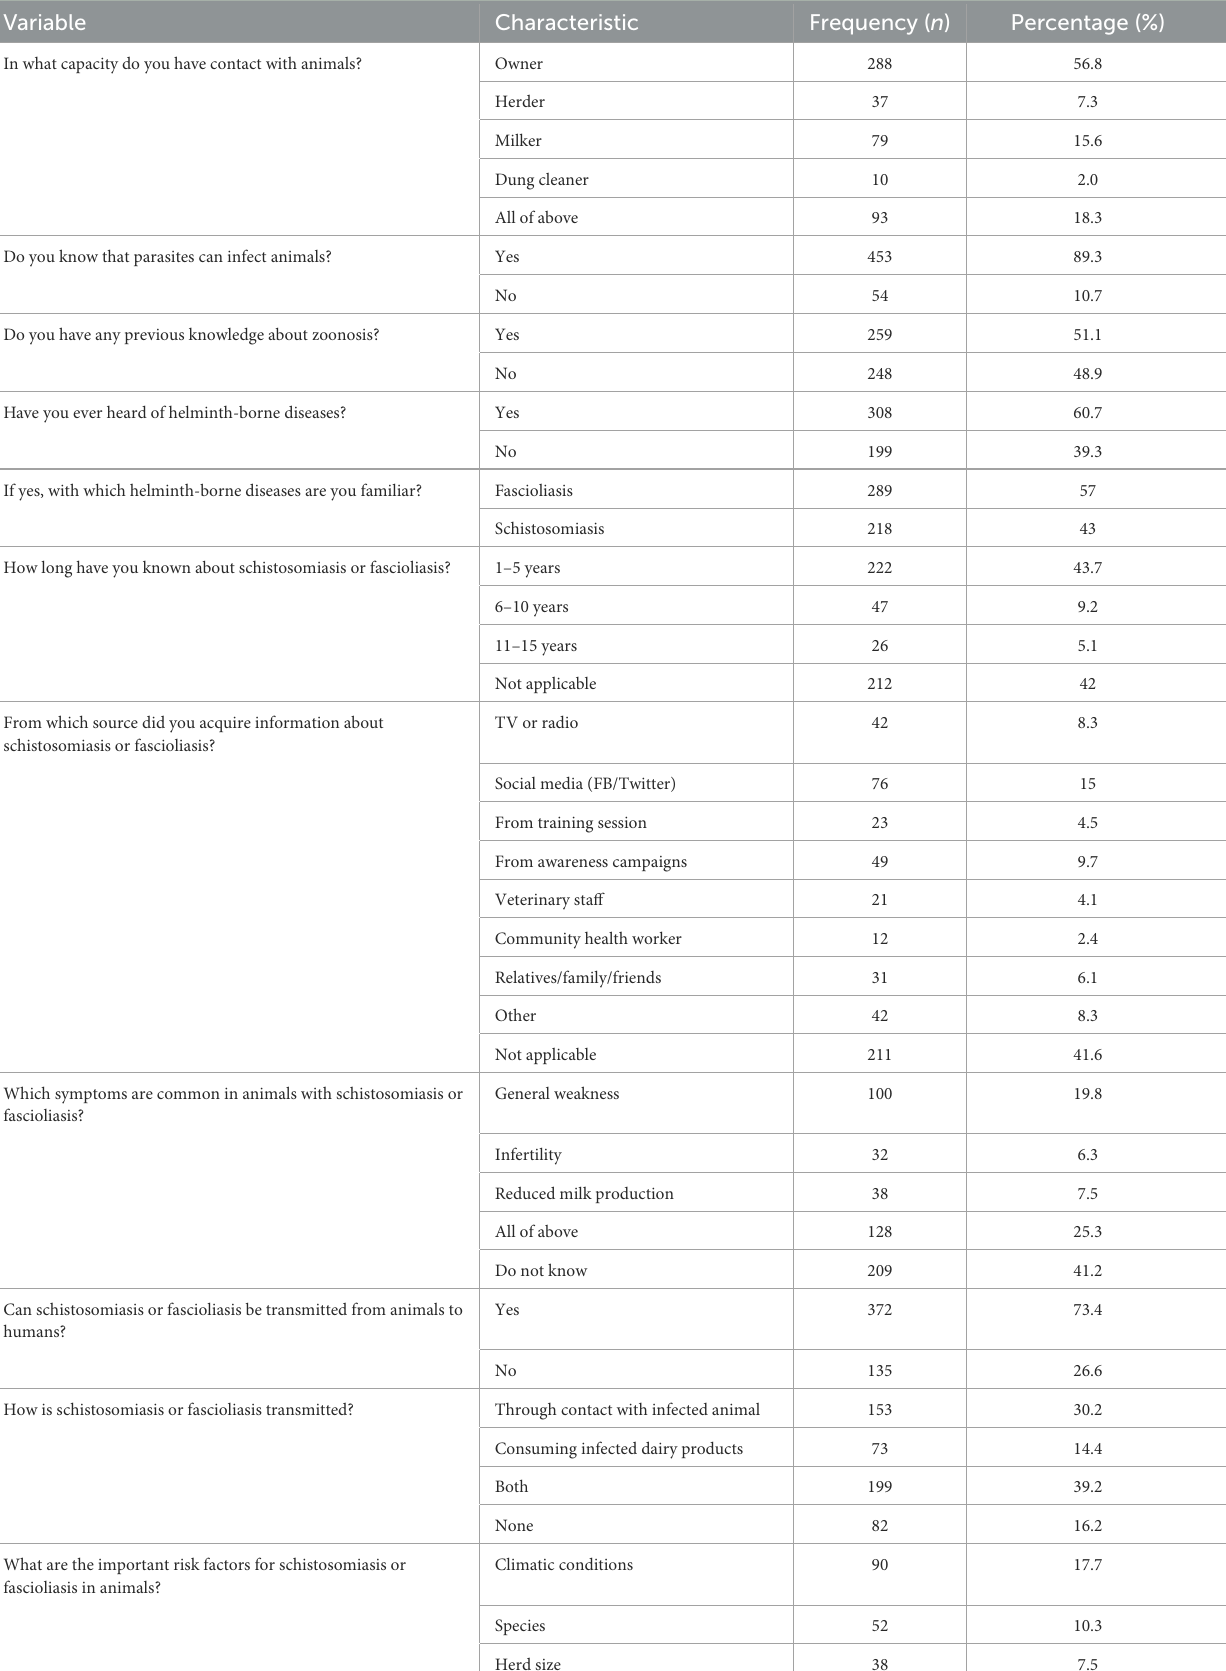
TABLE 3 Participants’ knowledge of helminth-borne diseases (schistosomiasis and fascioliasis). Variable